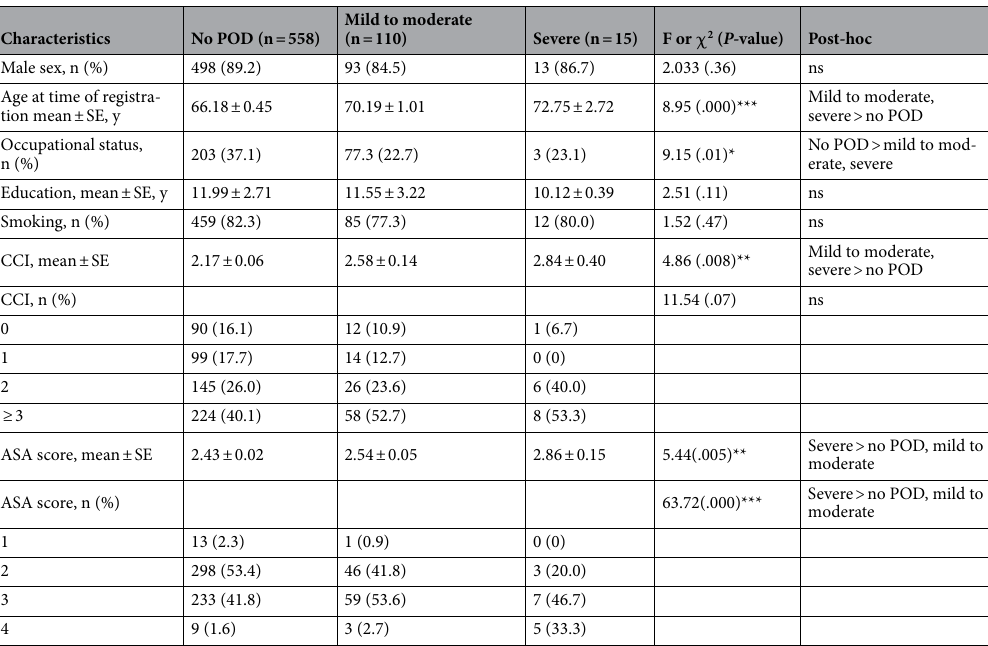
Table 1. Demographic characteristics and comorbidities according to POD development. POD postoperative delirium, SD standard deviation, SE standard error, CCI Charlson comorbidity index, ASA American Society of Anesthesiologists. * P < .05, ** P < .01, *** P <